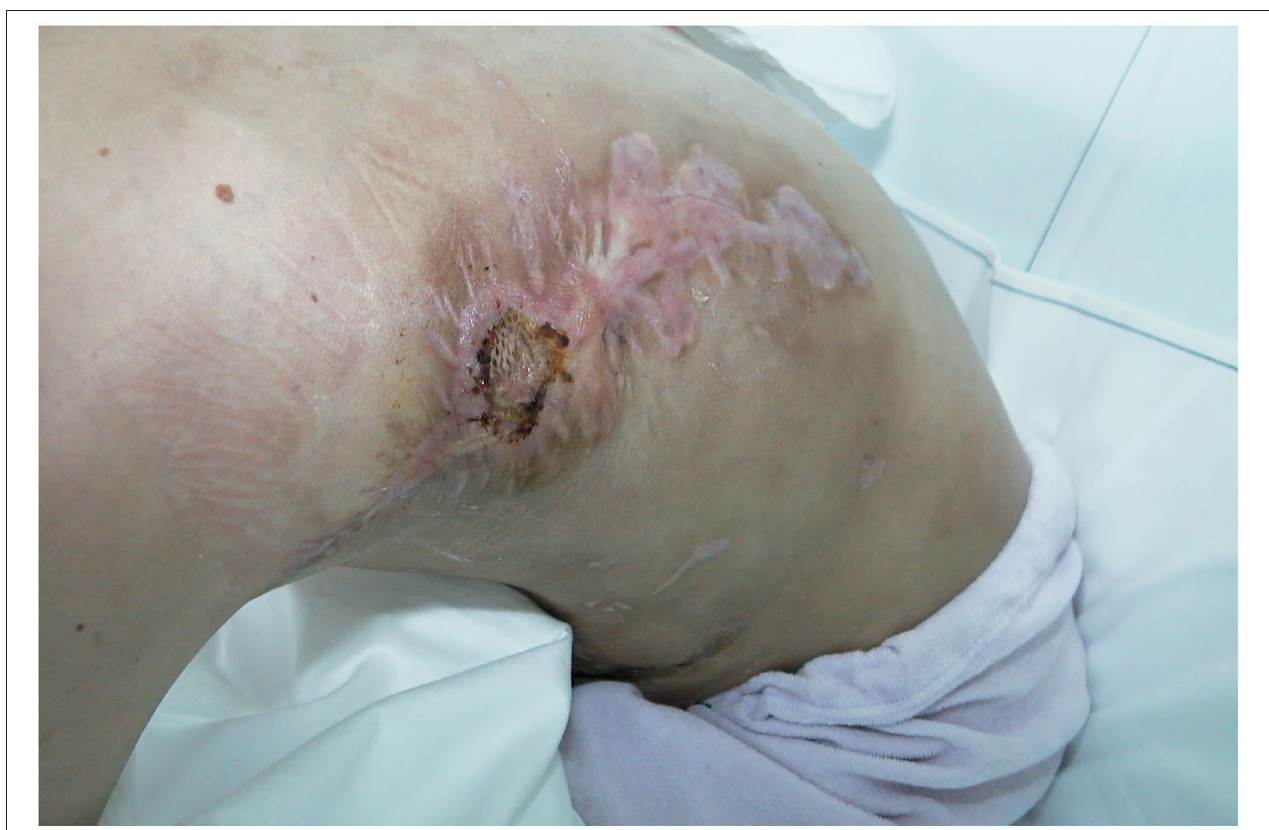
FIGURE 13 | Minimal wound dehiscence at donor site on 3 months follow-up treated with split thickness skin graft (STSG).